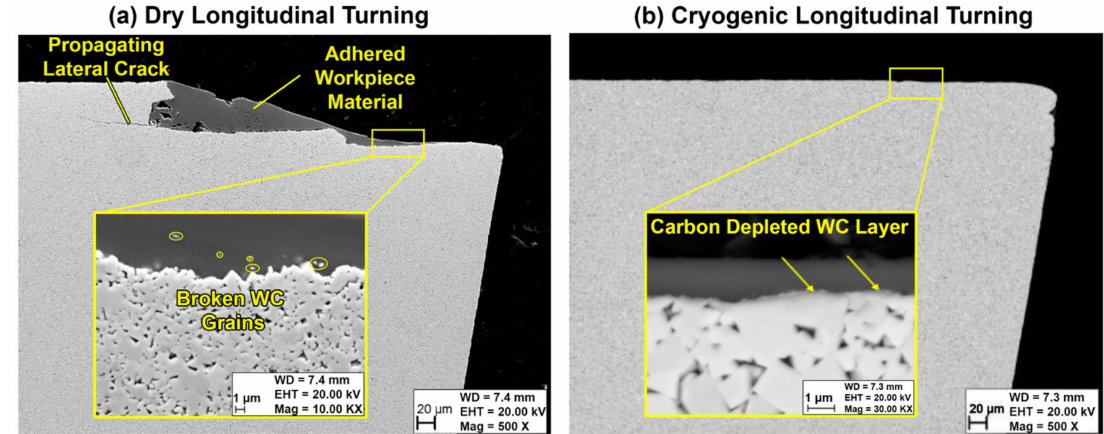
Figure 16. SEM Images for the cross-sections of the ( a ) dry and ( b ) cryogenic cutting insert.